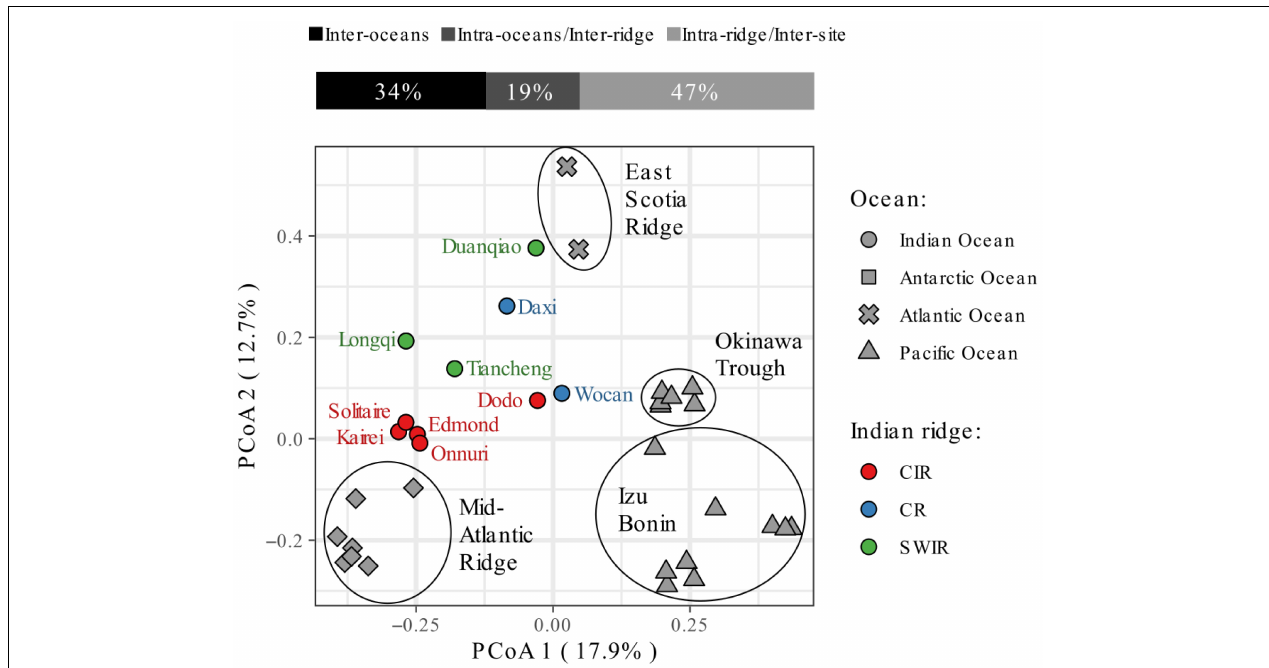
FIGURE 2 | Partition of the variance in community composition (genus level) across hydrothermal vents in the Indian, Antarctic, Atlantic, and West Pacific oceans. The Principal Coordinate Analysis (PcoA) plot is based on the Jaccard distance between vent sites. The presence/absence of taxa was compiled from Wang et al. (2021); Nakajima et al. (2014), Sun et al. (2020), and Kim et al. (2020), building upon Copley et al. (2016) and is provided as Supplementary Material with additional β -diversity indices. All hierarchical levels (inter-ocean and inter-ridge) significantly contribute to the observed differences in community composition at the genus level (db-RDA p -value = 0.001). ANOSIM analyses also support the ocean- and ridge-level groupings of vent communities (significance = 1e-04) with dissimilarities across mid-ocean ridges higher than across oceans (ANOSIM statistic R = 0.8 and 0.59, respectively). Within the Indian Ocean, ridge-level groups are statistically significant but less supported (ANOSIM significance = 0.0245). Note that the species lists for CR vents are likely incomplete due to lower sampling